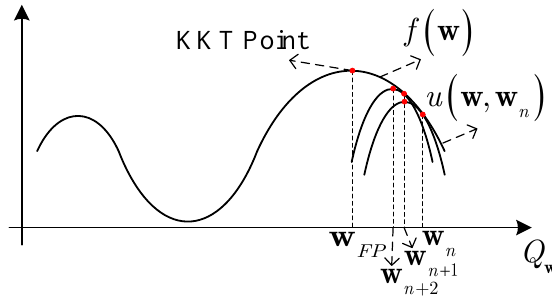
Figure A1. Convergency of the proposed iterations. Karush–Kuhn–Tucker